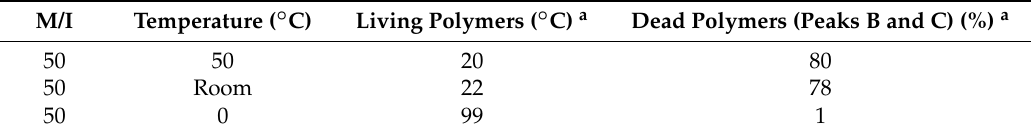
Table 2. Characterization of poly( N ε -trifluoroacetyl- L -lysine) samples by nonaqueous capillary electrophoresis (NACE). Table reproduced with permission from reference